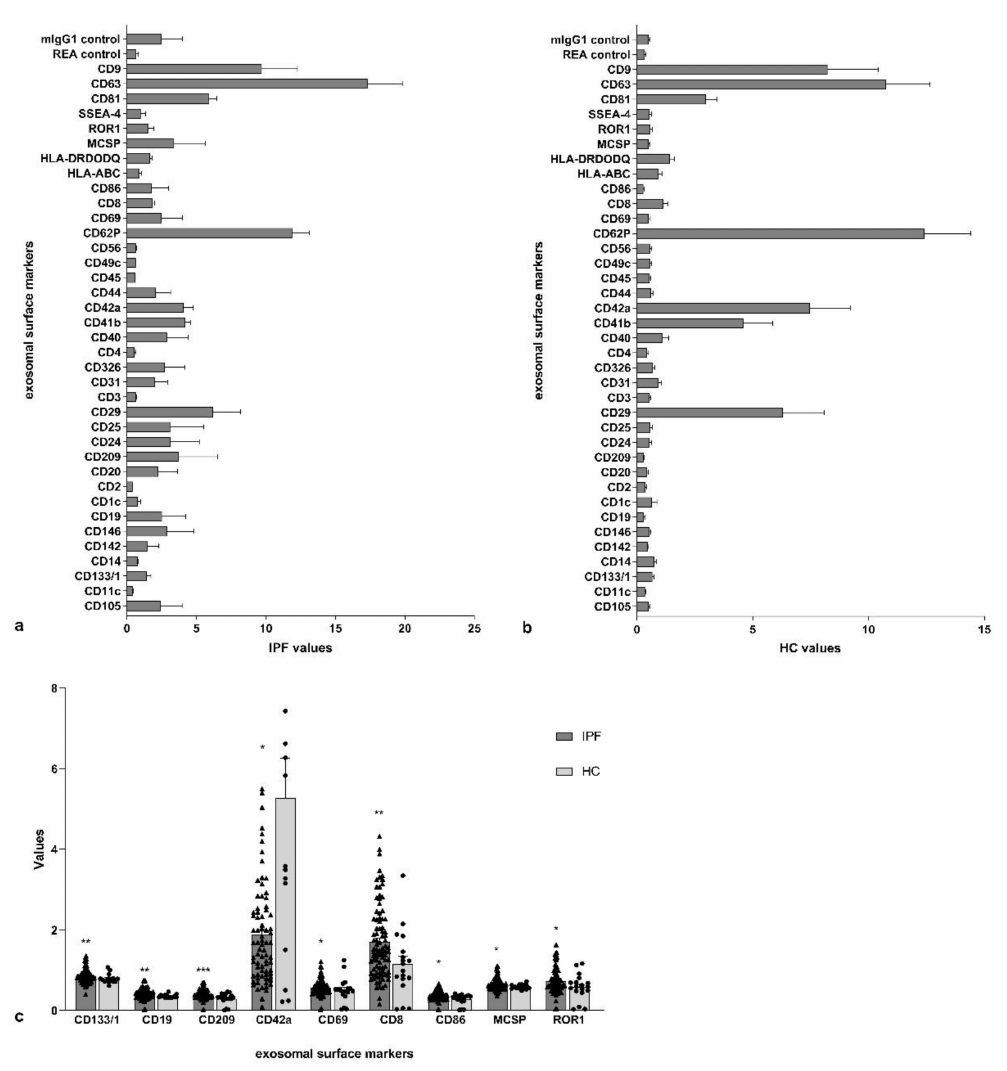
Figure 3. Extracellular vesicle surface marker values and the main differences between the two subgroups. ( a ) Exosomal surface epitope values in idiopathic pulmonary fibrosis (IPF) patients; ( b ) Exosomal surface epitope values in healthy controls (HC); ( c ) the significant differences of exosomal surface epitope values between idiopathic pulmonary fibrosis (IPF) patients and healthy controls (HC). (* p : 0.0332; ** p : 0.0021; *** p :